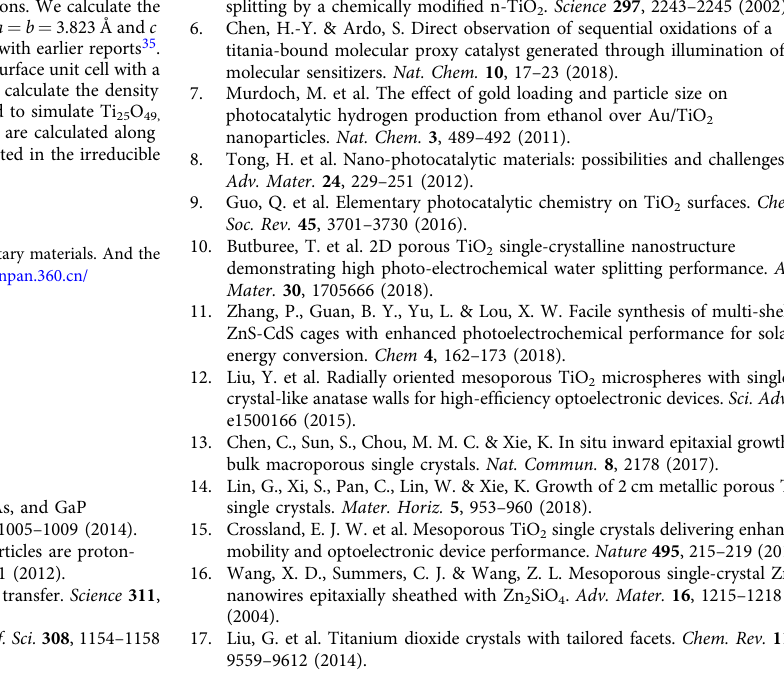
eV is used, and the energies and residual forces are converged to 10 − 6 eV and 0.02 eVÅ − 1 in the process of electronic and geometric optimizations. We calculate the unit cell of anatase TiO 2 and obtained the lattice parameters: a = b = 3.823 Å and c = 9.683Å (with a 8 ×8 ×3 k-point grid) which is consistent with earlier reports 35 . As shown in Supplementary Fig. 10, the TiO 2 (101) − (1 × 4) surface unit cell with a wide vacuum layer (10.410× 15.295 × 25.474 Å) is chosen to calculate the density of states for TiO 2 and one to four Ti atoms are intermingled to simulate Ti 25 O 49, Ti 12 O 23, Ti 9 O 17 and Ti 7 O 13 and the dipole moment of them are calculated along the z direction, respectively. K-point grids 3 ×2 ×1 are adopted in the irreducible Brillouin zone for this superstructure model. Data availability All reported data are included in the manuscript and supplementary materials. And the